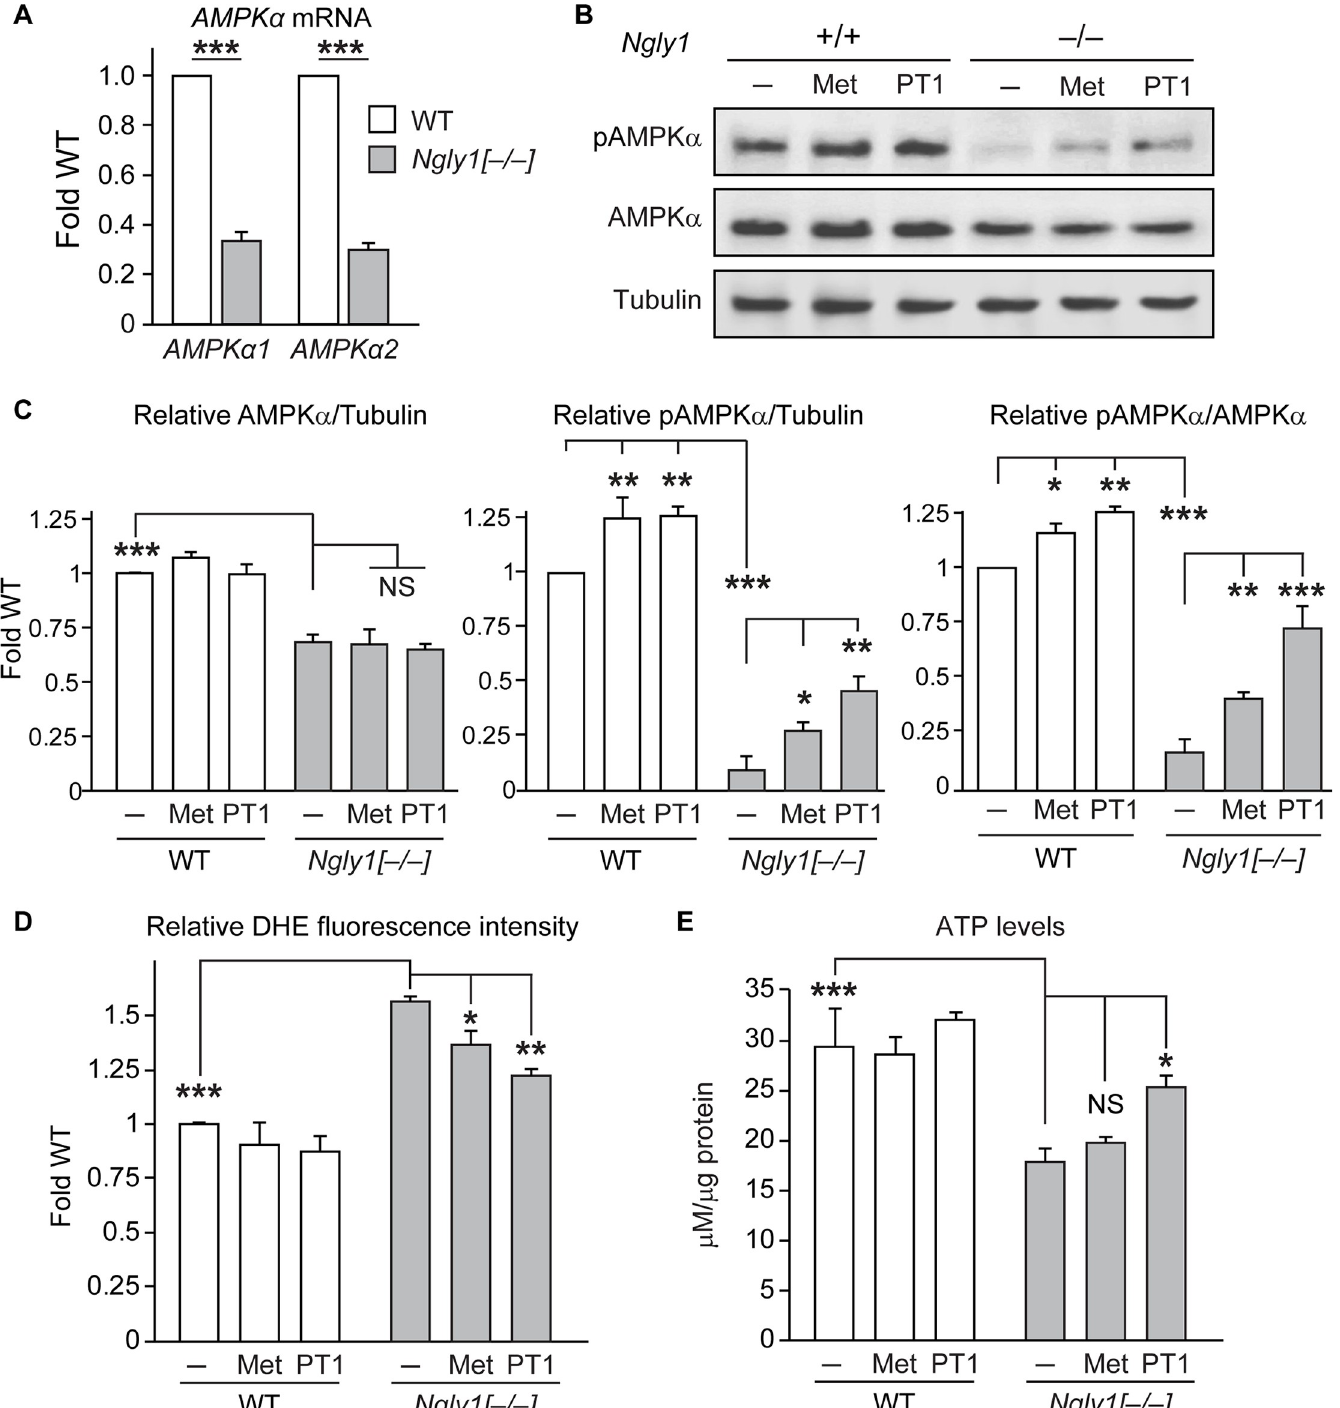
Fig 4. Reduced AMPK α level in Ngly1 –/– MEFs and partial rescue of energy metabolism defects in these cells by AMPK activators. (A) qRT-PCR assays show reduced AMPK α 1 and AMPK α 2 mRNA expression levels in Ngly1 –/– MEFs compared to wild-type MEFs. (B-D) Western blots show reduced levels of AMPK α and pAMPK α proteins in Ngly1 –/– MEFs. Treatment of AMPK activators metformin (Met) and PT1 increased pAMPK α levels without affecting AMPK α levels. Graphs show relative levels of (C) AMPK α /Tubulin, pAMPK α /Tubulin and pAMPK α /AMPK α ratios based on quantification of Western blots. (D-E) Graphs show relative ROS levels in terms of oxidized-DHE fluorescent intensity (D) and ATP levels (E) in the indicated cells and conditions. Data represent mean ± SD of three independent experiments. Significance is ascribed as � P < 0.05, �� P < 0.01 and ��� P < 0.001. NS, not significant.